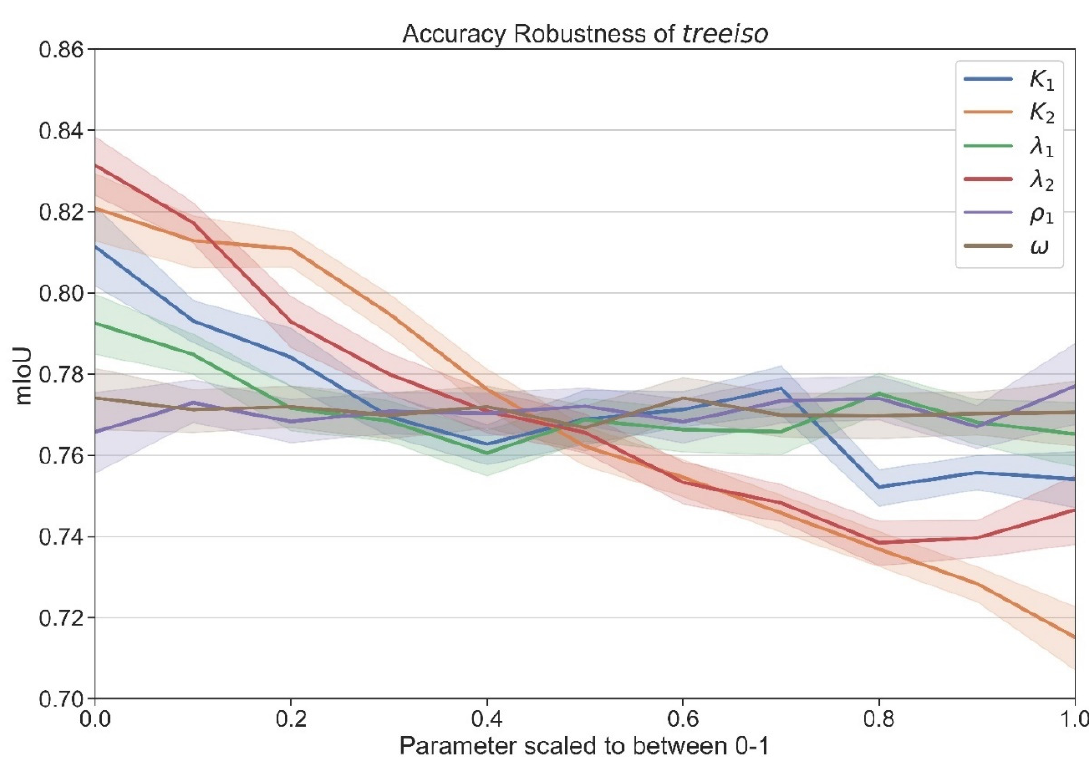
Figure 9. Summary of accuracy response conditional to separate parameter variation based on the 10,000 samples. All parameters were scaled between 0–1 based on the ranges in Table 2. The lines connect the means of the mIoU distributions within each interval, and the band around each line illustrates the 95% confidence